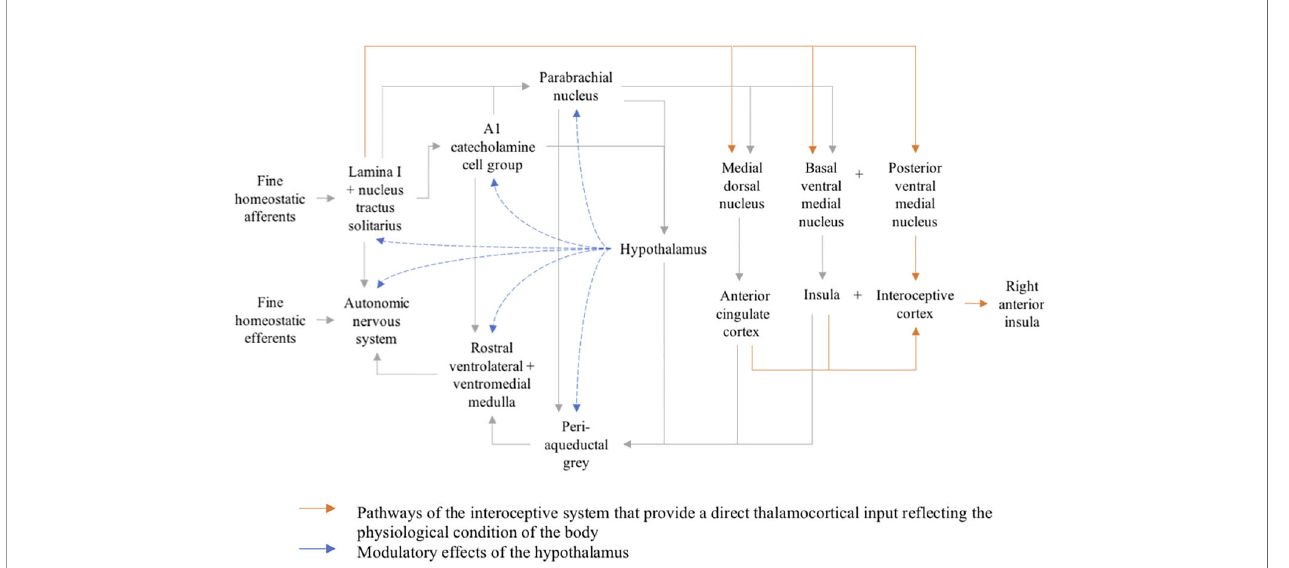
FIGURE 1 | Organizational map of the interoceptive